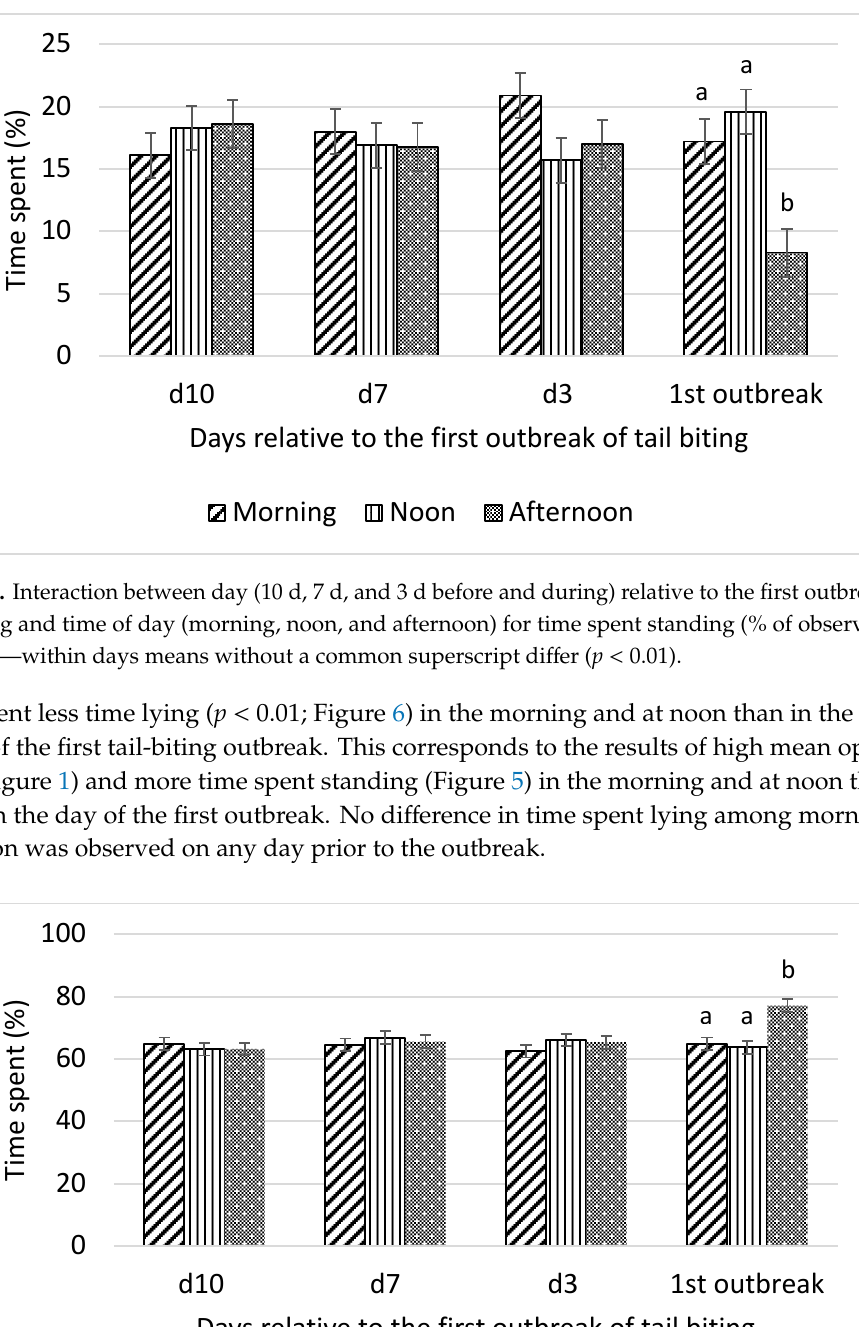
11 of 17 . Figure 4. Interaction between day (10 d, 7 d, and 3 d before and during) relative to the first outbreak of tail biting and time of day (morning, noon, and afternoon) for kurtosis of optical flow; ab —within days means without a common superscript differ ( p < 0.01).